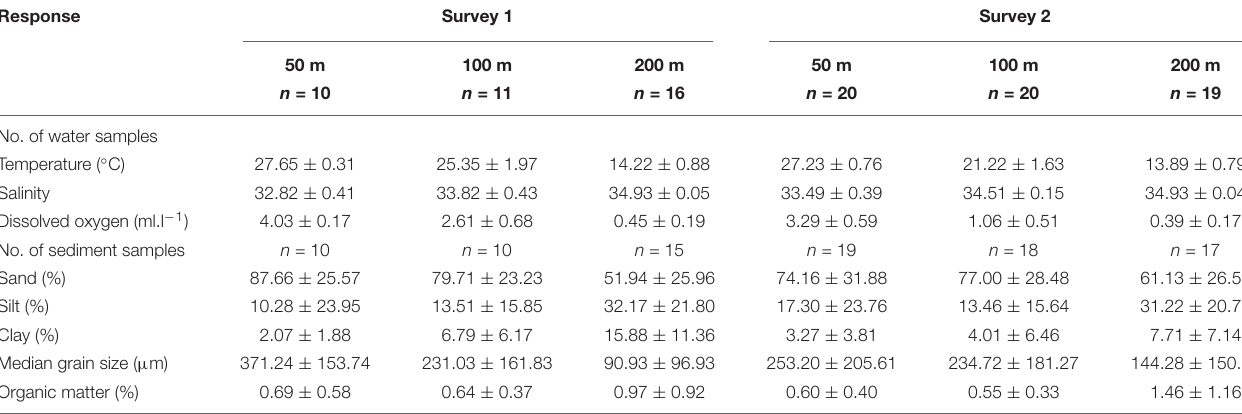
TABLE 1 | Hydrographic and sediment characteristics at each depth stratum [mean ± SD, n = No. of samples].